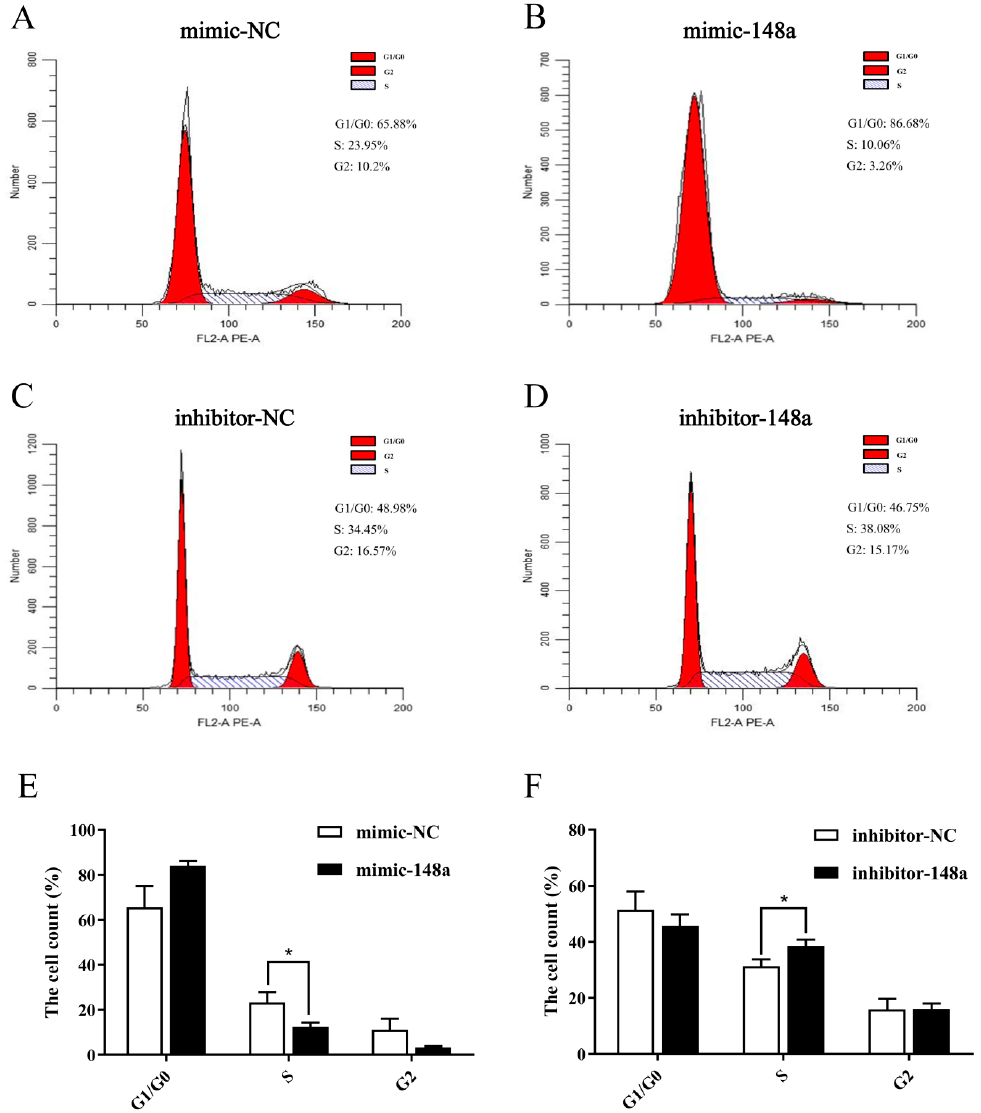
Figure 6. The miR-148a suppressed ovine preadipocyte proliferation. ( A , B ) The percentage of preadipocytes in different stages of mitosis was detected by flow cytometry after the preadipocytes were transfected with miR-148a mimic and NC. ( C , D ) The percentage of preadipocytes in each mitosis stage was detected by flow cytometry after the preadipocytes were transfected with the miR-148a inhibitor and NC. ( E , F ) The statistics of flow cytometry results. The results are depicted as the mean ± SD ( n = 3), * p < 0.05.